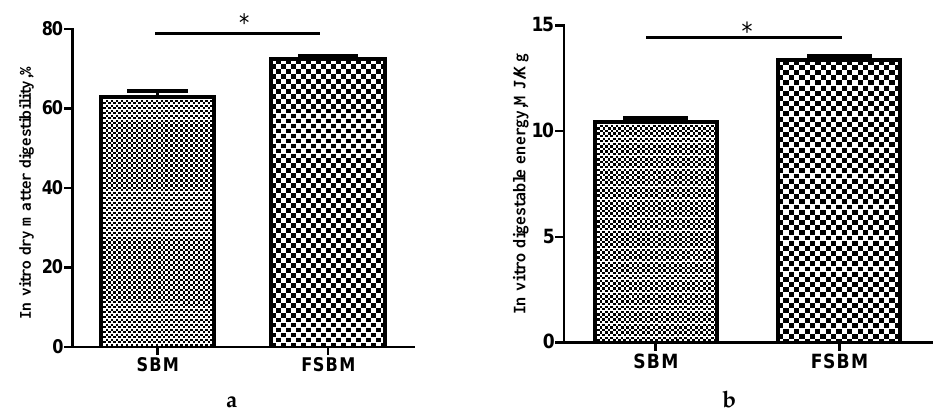
Figure 2. In vitro digestibility of SBM and FSBM. ( a ) In vitro dry matter digestibility of SBM and FSBM; ( b ) In vitro digestible energy of SBM and FSBM. * indicates significant differences at p < 0.05.